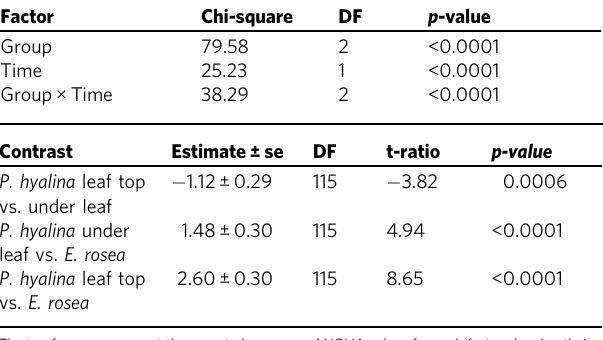
The top four rows present the repeated measures ANOVA values for each factor showing their respectiveChi-squareteststatistic,degreesoffreedom(DF),and p -value.Thebottomfourrows display the post-hoc Tukey ’ s Test results for P. hyalina leaf top, P. hyalina under leaf, and E. rosea groups including the Tukey ’ s test estimate±standard error (se), degrees of freedom (DF), t- ratio, and corresponding p-